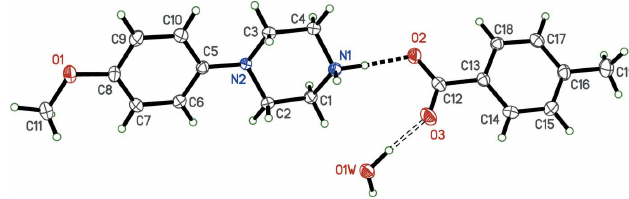
Figure 2 An ellipsoid plot (50% probability) of II . The solid dashed line denotes an N—H (cid:2)(cid:2)(cid:2) O hydrogen bond, while the open dashed line shows an O— H (cid:2)(cid:2)(cid:2) O hydrogen bond. Hydrogen atoms are drawn as arbitrary circles.